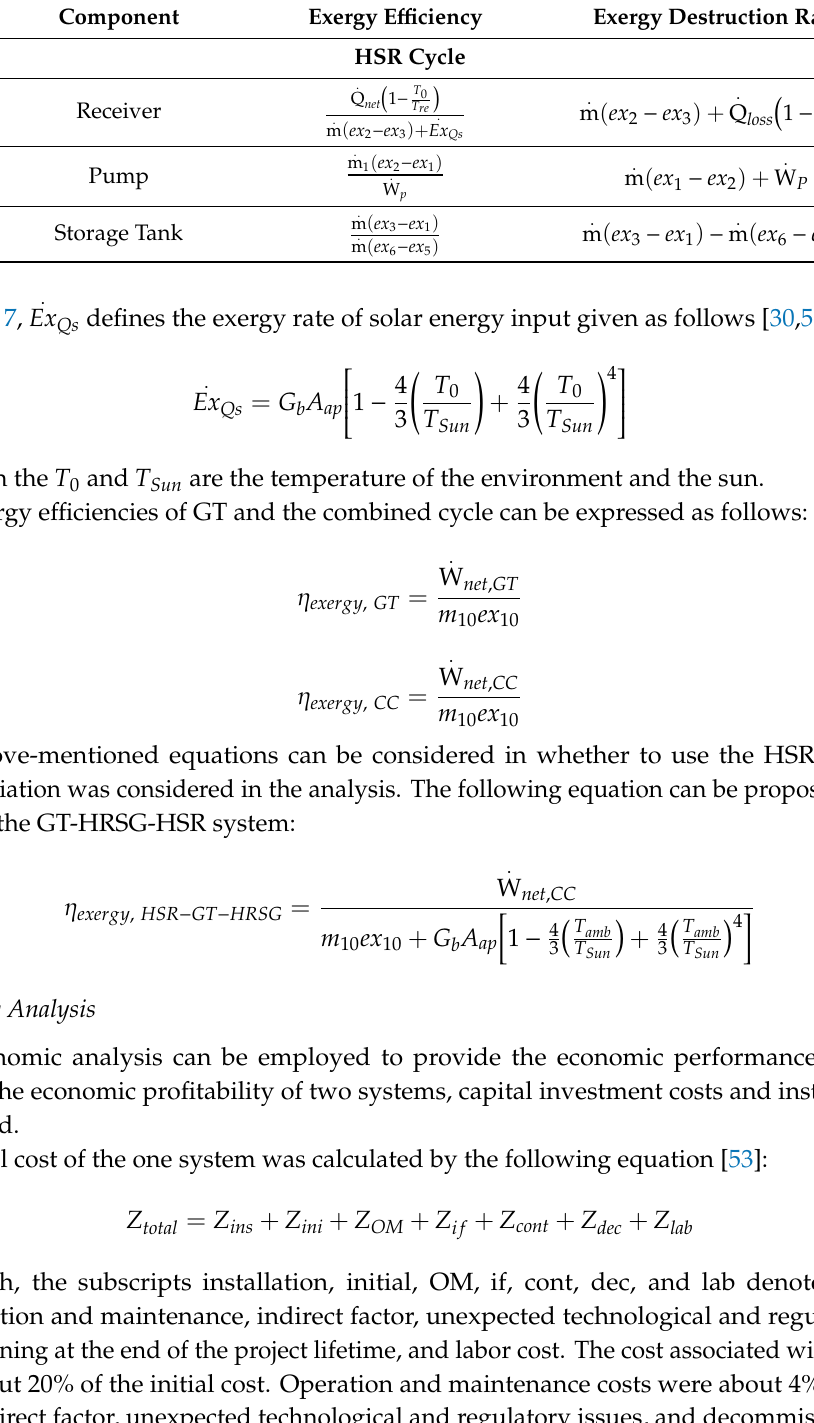
Table 6. Equations of exergy balance and exergy destruction rate for the HSR cycle [33–35]. No. Component Exergy E ffi